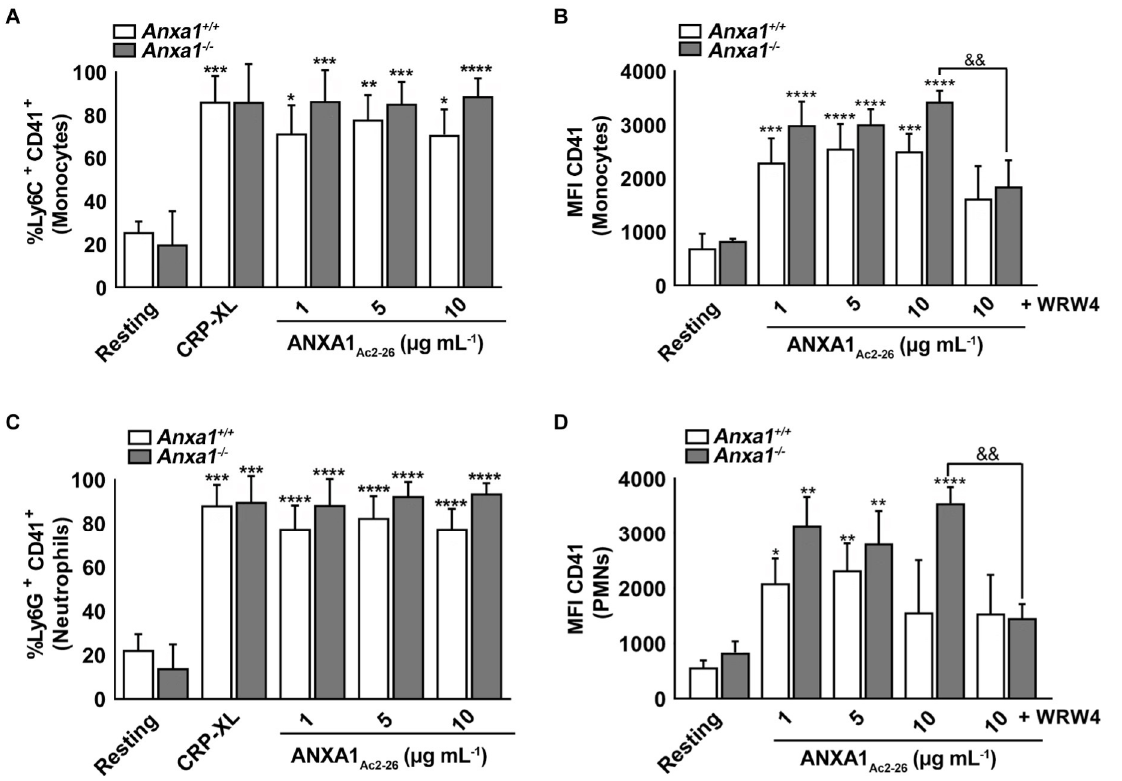
Figure 4. Effect of ANXA1 Ac2-26 in the stimulation of platelet–leukocyte interactions. ( A ) The level (percentage) of platelet–monocyte aggregates within the total monocyte population in whole blood from control and Anxa1 − / − mice upon treatment with CRP-XL (10 µ g mL − 1 ) or various concentrations of ANXA1 Ac2-26 . ( B ) The level of CD41 within platelet–monocyte aggregates in whole blood from control and Anxa1 − / − mice upon incubation with various concentrations of ANXA1 Ac2-26 in the presence or absence of WRW4 (5 µ M). ( C ) The percentage of platelet–neutrophil aggregates within the total neutrophil population in whole blood obtained from the control and Anxa1 − / − mice upon treatment with CRP-XL (10 µ g mL − 1 ) or different concentrations of ANXA1 Ac2-26 . ( D ) The level of CD41 in platelet–neutrophil aggregates in whole blood of the control and Anxa1 − / − mice upon incubation with various concentrations of ANXA1 Ac2-26 in the absence or presence of WRW4 (5 µ M). Data represent mean ± S.D. ( n = 4). Statistical analysis was carried out using two-way ANOVA for repeated measures followed by Sidak’s multiple comparisons test for ( A , C ) and Tukey’s multiple comparisons test for ( B , D ). * p < 0.05, ** p < 0.01, *** p < 0.001 and **** p < 0.0001 (same applies to & symbol); ‘*’ represents the comparison between the treated and untreated samples in relevant mice group; ‘&’ represents the comparison between the control and Anxa1 − / − mice in relevant data